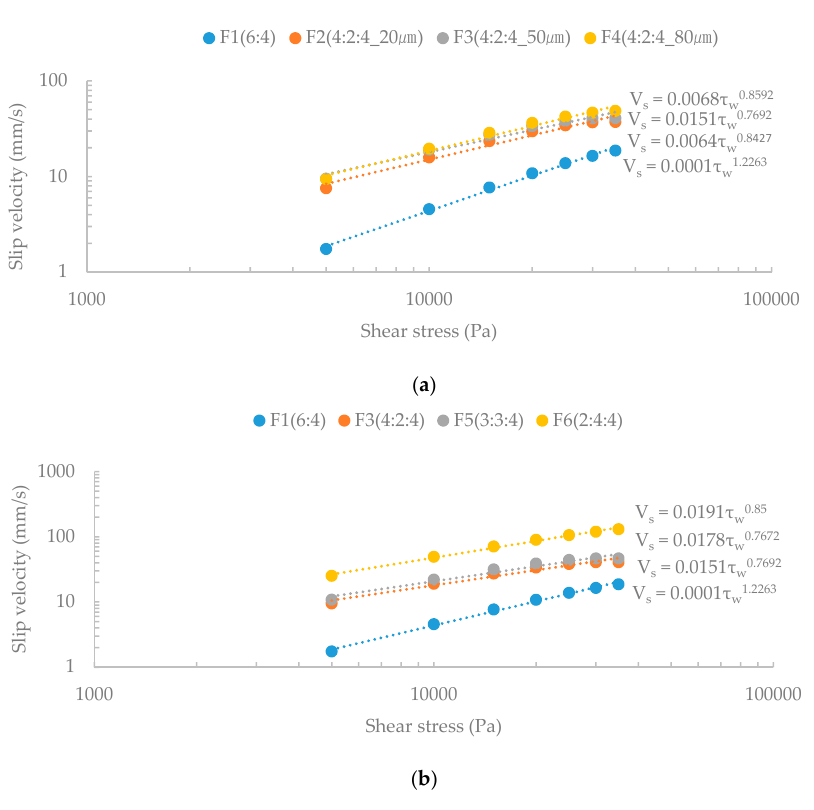
Figure 7. Slip velocity versus shear stress for different polymethyl methacrylate (PMMA) volume fractions ( a ) and sizes ( b ).